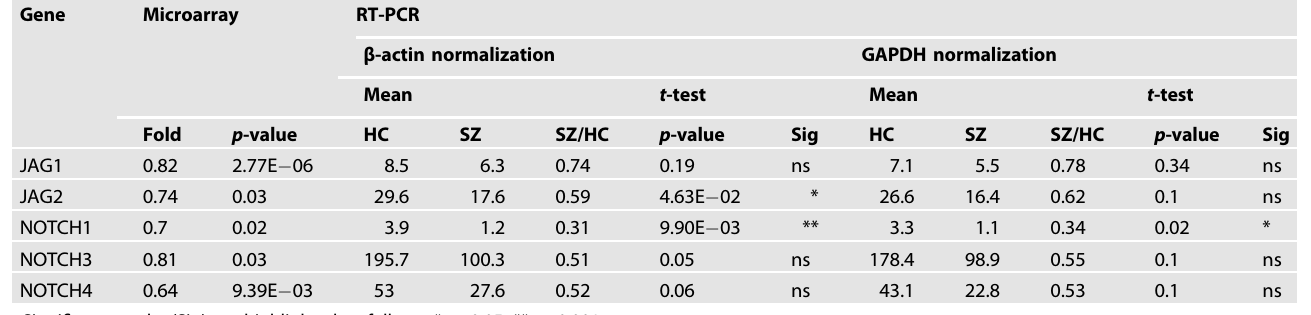
Table 1. Microarray and quantitative real time-PCR results of the Notch – JAG pathway gene expression in human olfactory neural epithelium from healthy controls (HC) and chronic schizophrenia patients